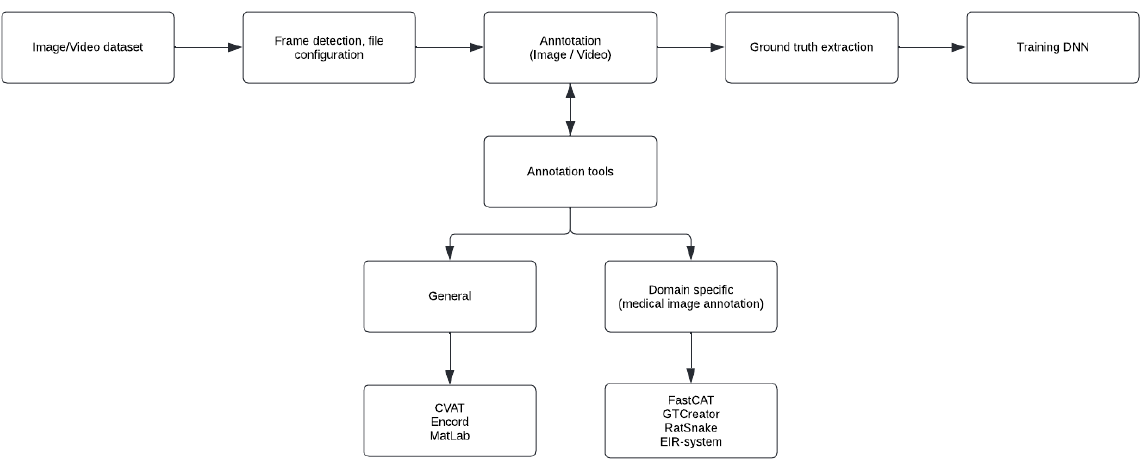
Figure 1. Schematic illustration of annotation tools’ role in training DNN for development of CCE, and whether those tools are defined as general or domain specific.